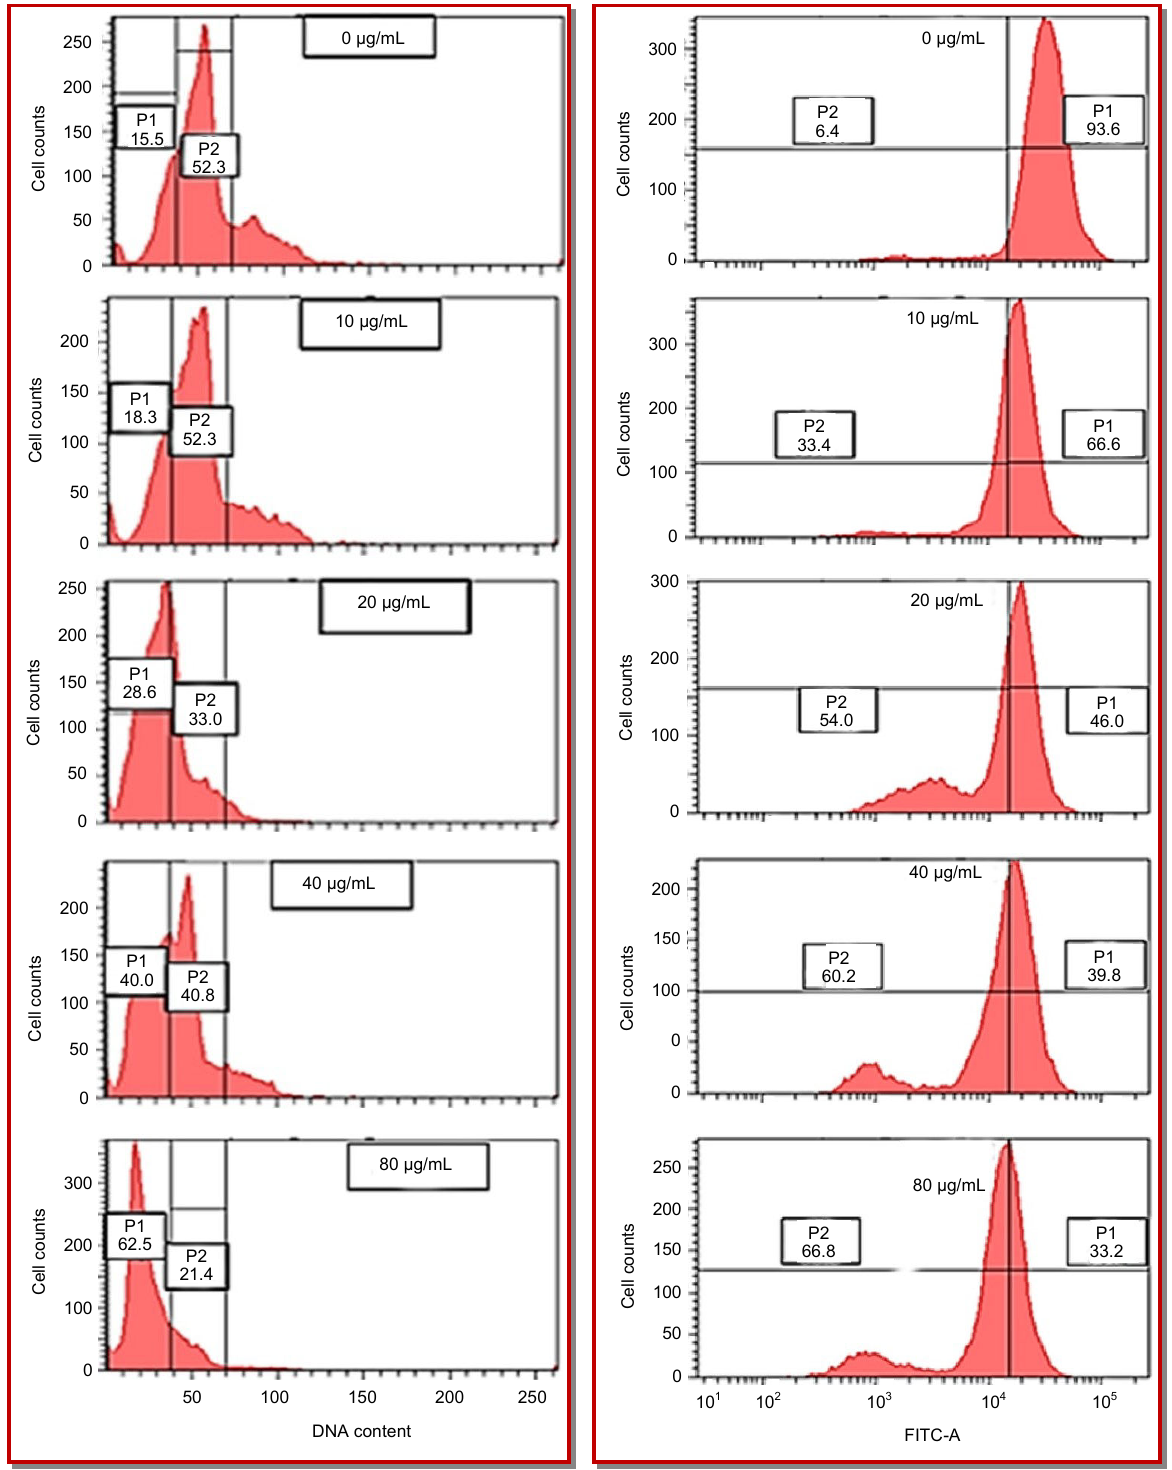
Figure 2: Methanol extract of P. macrophylla induced cell cycle arrest in COLO-205 cells at G 0 /G 1 phase of cell cycle. Expo- sure of cells with different concentrations of extract caused dose dependent cell cycle arrest at G 0 /G 1 phase and triggered apoptosis by increasing accumulation of cells at sub-G 0 phase